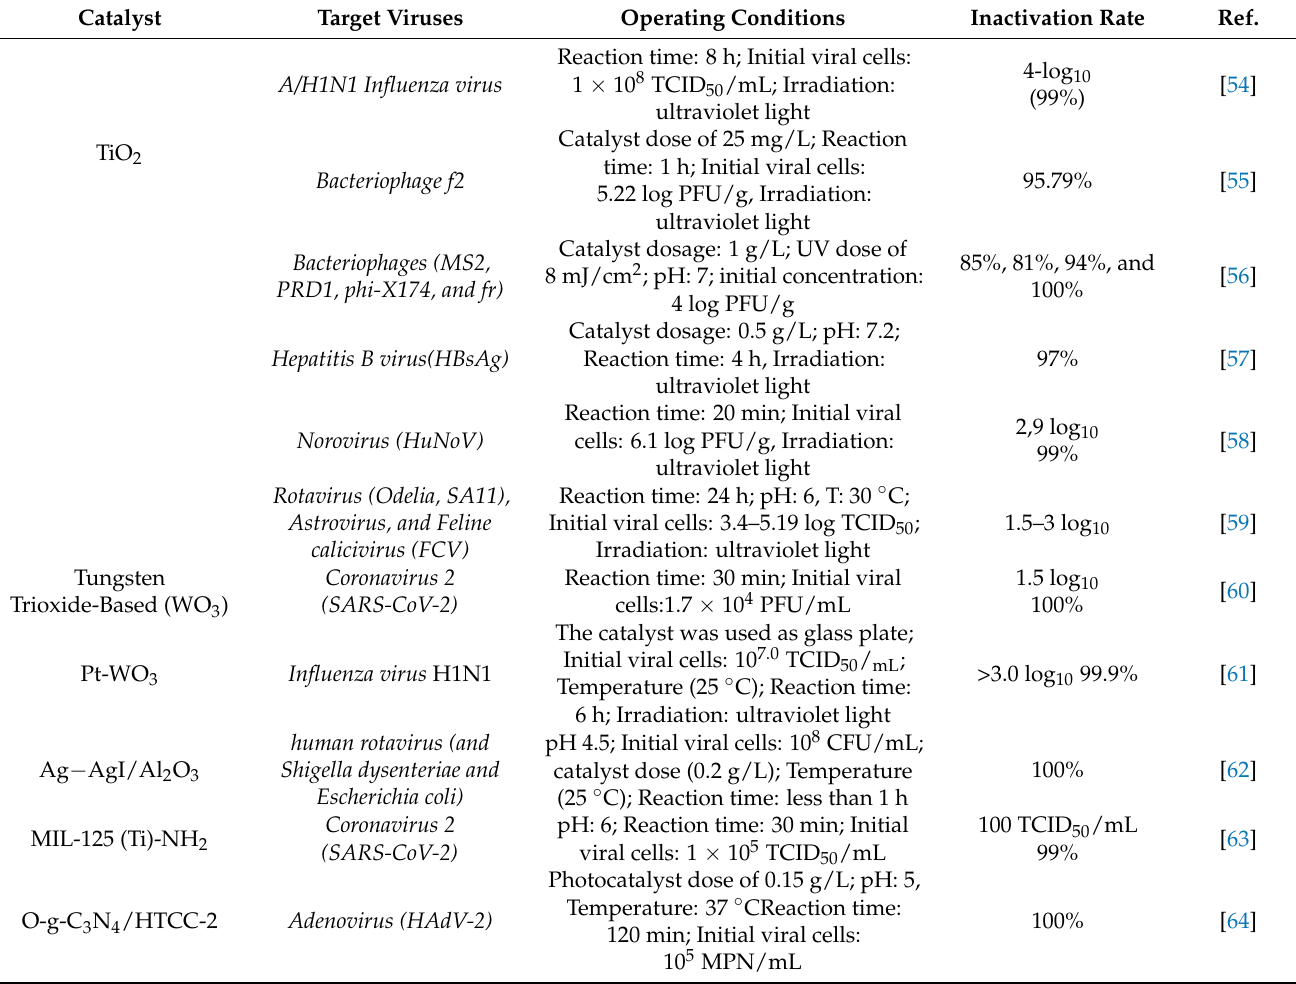
Table 2. Semiconductors for viruses’